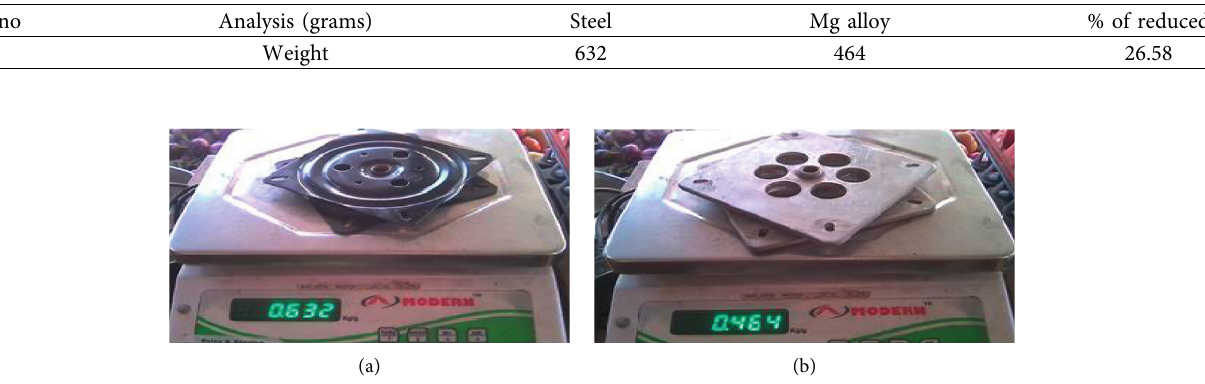
Figure 16: Weight difference between Mg alloy and A3 steel swivel plate. (a) Weight of A3 steel swivel plate. (b) Weight of Mg alloy swivel plate.